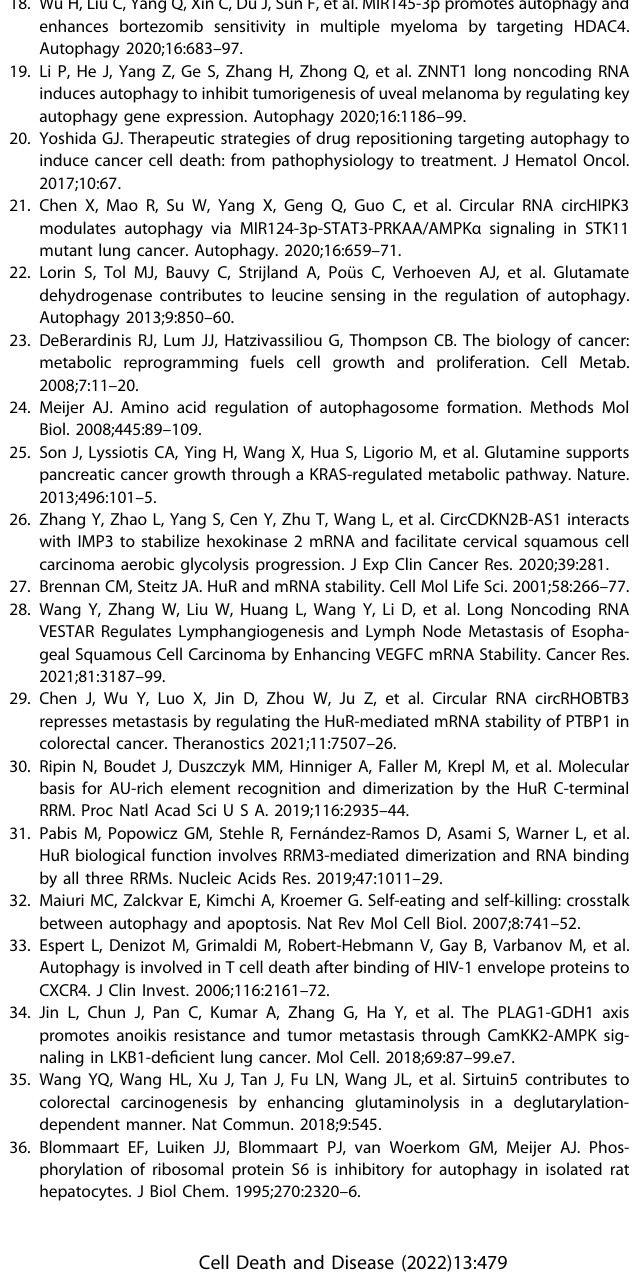
Fig. 6 HuR Inhibitory peptide suppresses cervical cancer progression in vitro and in vivo by blocking circTICRR-HuR interaction. A The schematic domain structure of HuR. B In vitro RNA pull-down assay depicting the circTICRR-HuR interaction from HeLa cells validated by western blot after incubation with full-length, or truncated3XFlag-tagged recombinant HuR protein. C Upper panel: the schematic structure of the SLGY (60-63 aa), F247/Y249, and F287/F289 residues of the HuR protein crucial for interacting with circTICRR. Lower panel: the inhibitory peptides sequence containing the core amino acids of HuR. D Biotin-labeled peptide pull-down assay revealing the interaction of Control peptide (CTL) (30 μ mol/L) or HIP (30 μ mol/L) with circTICRR in HeLa cells. E In vitro RNA pull-down assay depicting the circTICRR/HuR interaction from HeLa cells validated by western blot after incubation with full-length, or mutant F287A/F289A of 3XFlag-tagged recombinant HuR protein. F Confocal images showing the distribution of synthesized inhibitory peptide (HIP-3: 30 μ mol/L) or control peptide (CTL-3: 30 μ mol/L) after incubation with SiHa and CaSki cells for 48 h. The nuclei were stained with DAPI (blue), while the membrane was stained with DiI (red). Scale bar, 20 μ m. G Protein pulled down by control oligo or circTICRR probe with HuR antibody was detected by western blot. Cell viability ( H ) was determined by CCK-8 assay, cell apoptosis ( I ) was measured by Flow Cytometry in the SiHa and CaSki cells treated with HIP-3 or CTL-3. J SiHa and CaSki cells treated with HIP-3 or CTL-3 for 72 h were incubated with the autophagy inhibitor CQ or Baf-A1 for another 6 h. Then the autophagy-related protein LC3B I/II was monitored by Western blotting. K SiHa and CaSki cells transfected with mRFP-GFP-LC3B for 24 h were incubated with HIP-3 or CTL-3 for another 48 h. The images were captured by confocal microscopy. Scale bar, 20 μ m. Images of tumors L , tumor volume and weight M , images of H&E and apoptotic cells ( N ) in the xenografts treated with HIP-3 or CTL-3 after collection of the tumors ( n = 5 for each group). Scale bar, 100 μ m. Data are representative of at least three independent experiments and presented as the mean ± SD. * p < 0.05, ** p < 0.01, *** p <